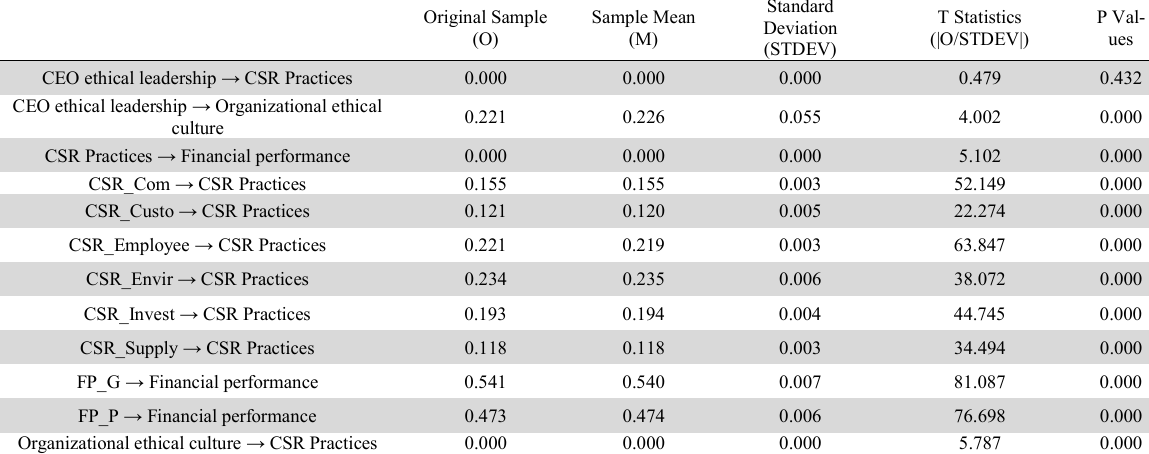
Bootstrap result and Path